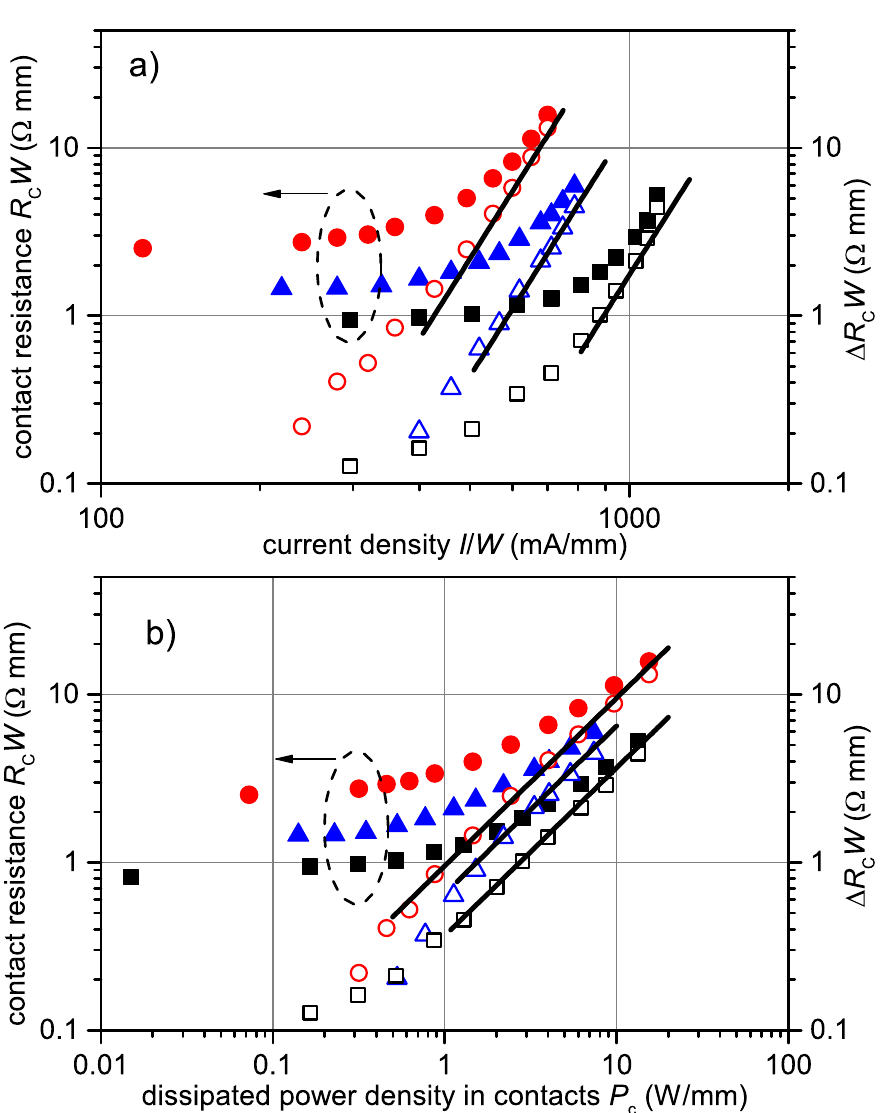
Figure 4. The dependence of the contact resistance R c on the current density I / W ( a ) and on the dissipated electric power density P c in contacts ( b ) for different samples; AlGaN/GaN (squares), AlGaN/AlN/GaN (triangles and circles). The dependence of the contact resistance change ∆ R c = R c − R c0 relatively to its low-field value is also presented (right-side axis). Lines are ( a ) and ∆ R c ∝ P c ( b ),